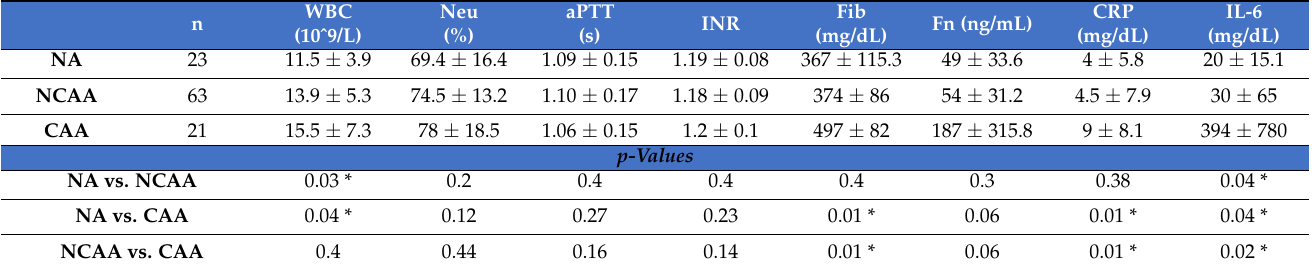
Table 1. Mean values, standard deviation (SD) and p -value of white blood cells (WBC), neutrophils (Neu), aPTT, INR, fibrinogen (Fib), ferritin (Fn), C-reactive protein (CRP), and Interleukine-6 (IL-6). NA = Not inflamed appendix. NCAA = not complicated acute appendicitis. CAA = complicated acute appendicitis. * = Statistically significant values.